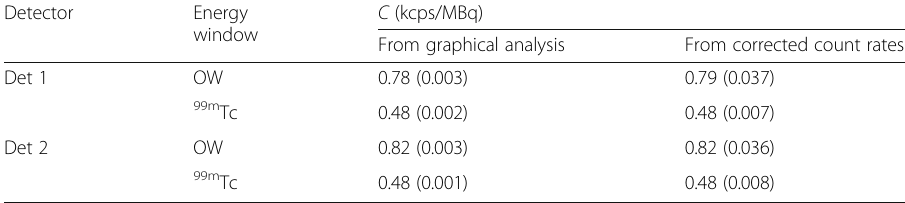
Table 3 Intrinsic sensitivity C EW from dead time corrected count rate measurements C (kcps/MBq) Detector Energy window From graphical analysis From corrected count rates Det 1 OW 0.78 (0.003)